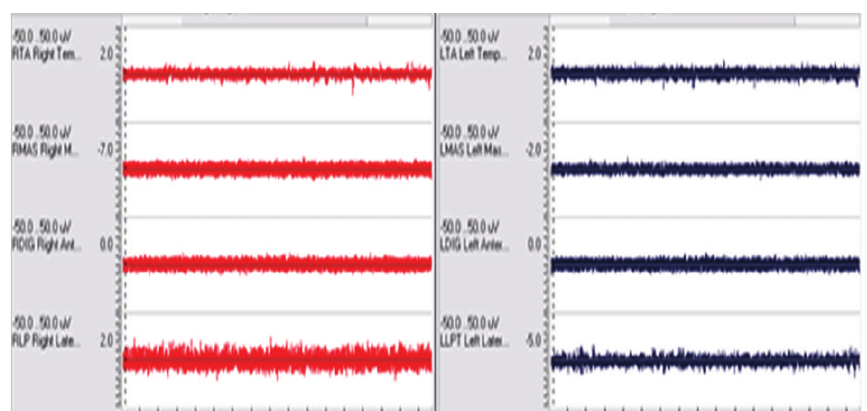
Figure 3: SEMG activity of the bilateral temporalis anterior (TA), masseter (MAS) suprahyoid (DIG), and lateral pterygoids (LP) at the initial baseline/postural resting position (Pre-TENS).